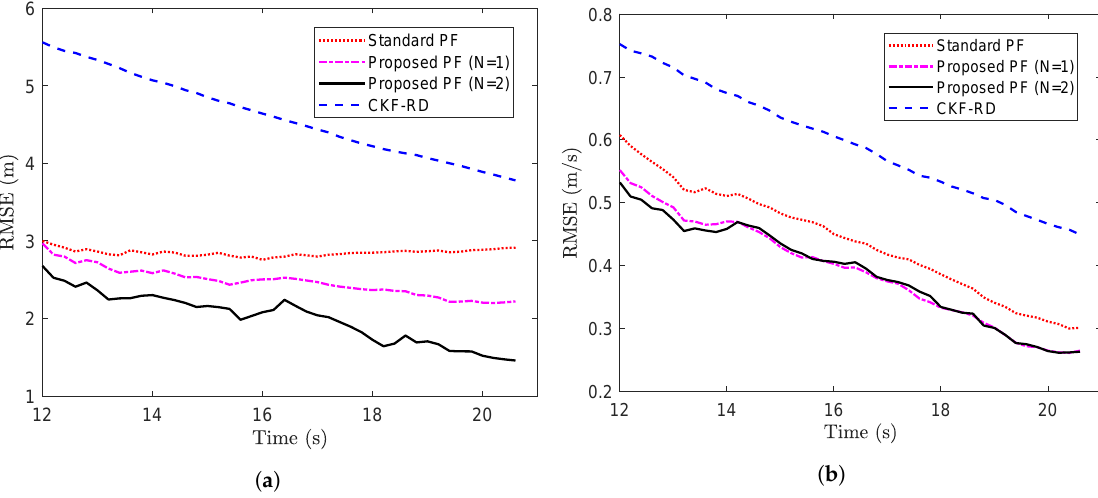
Figure 7. RMSE vs. time steps with p = 0.5. ( a ) State x 1, k ( b ) State x 2, k (Problem